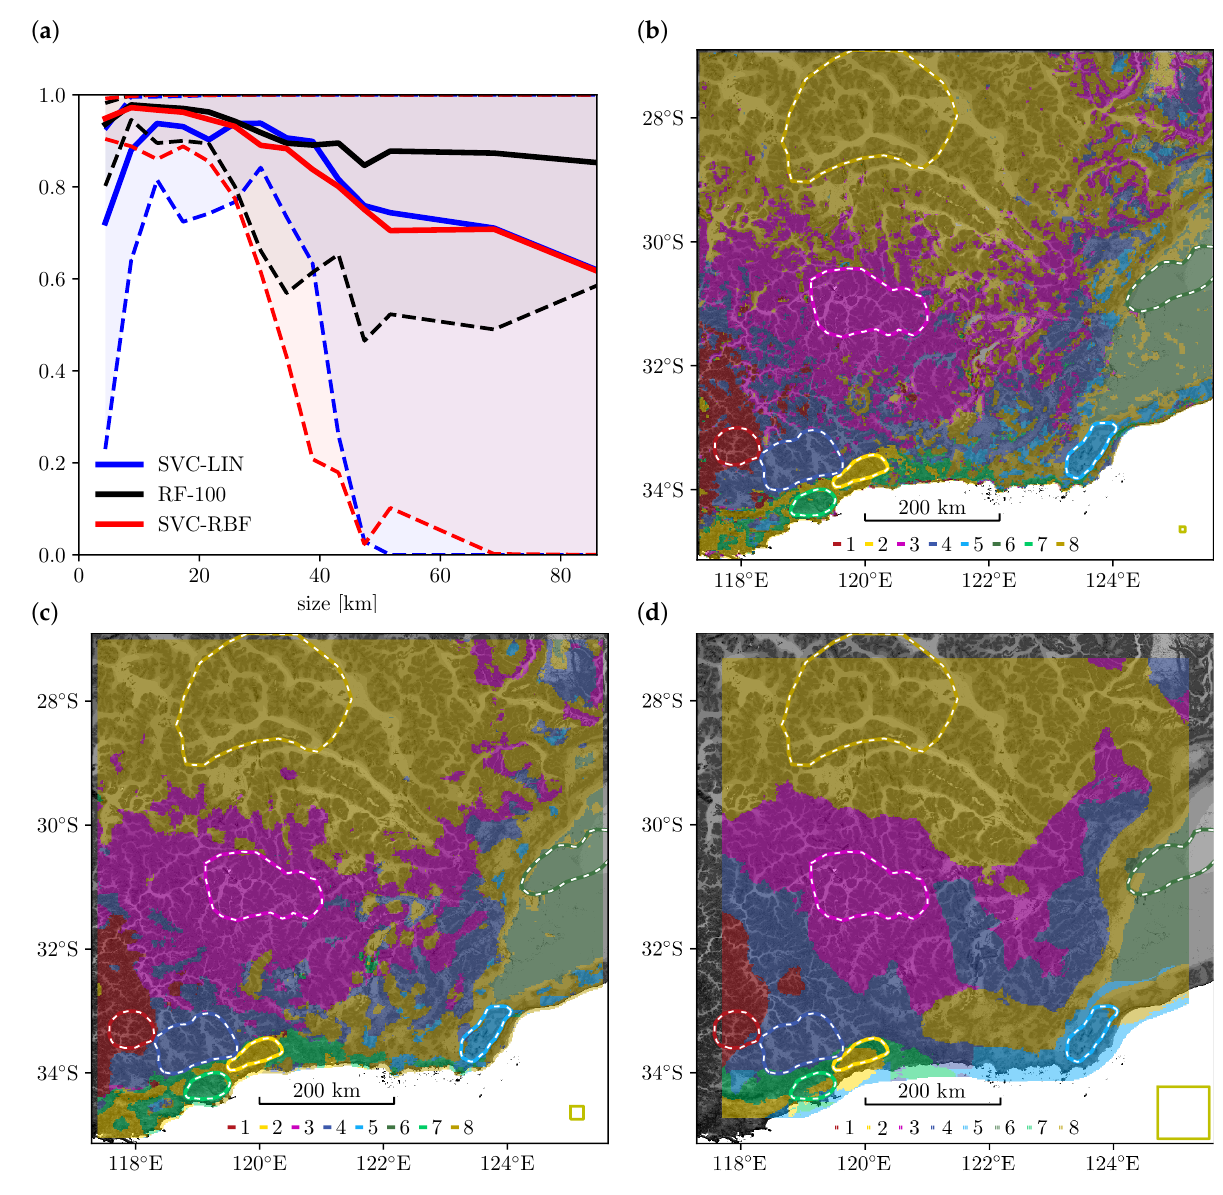
Figure 4. ( a ) Solid lines show the overall accuracy vs. block size, per ML algorithm. Shaded areas indicate the range of per-class accuracy. ( b ) The highest accuracy score of 97.8% is produced by RF-100 at s = 8.7km, which is still a rather small tile size and results in a somewhat noisy map. The yellow square in the lower right corner represents a tile. ( c ) Increasing the tile size to s = 21km reduces accuracy slightly to 96.3% but produces a much cleaner map. ( d ) At the largest s = 86km, a lack of training samples severly degrades accuracy for classes 2 and 7 whose training regions are